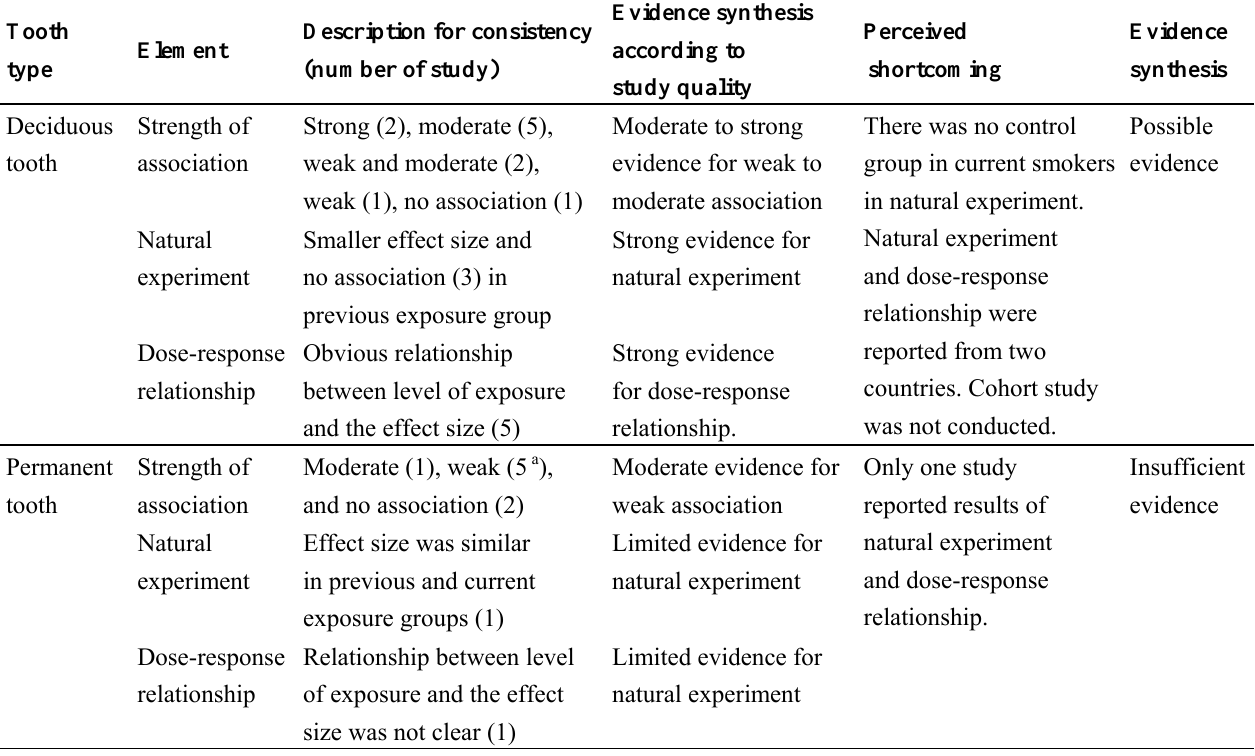
Table 7. Summary of results to evaluate the causal association between SHS and dental